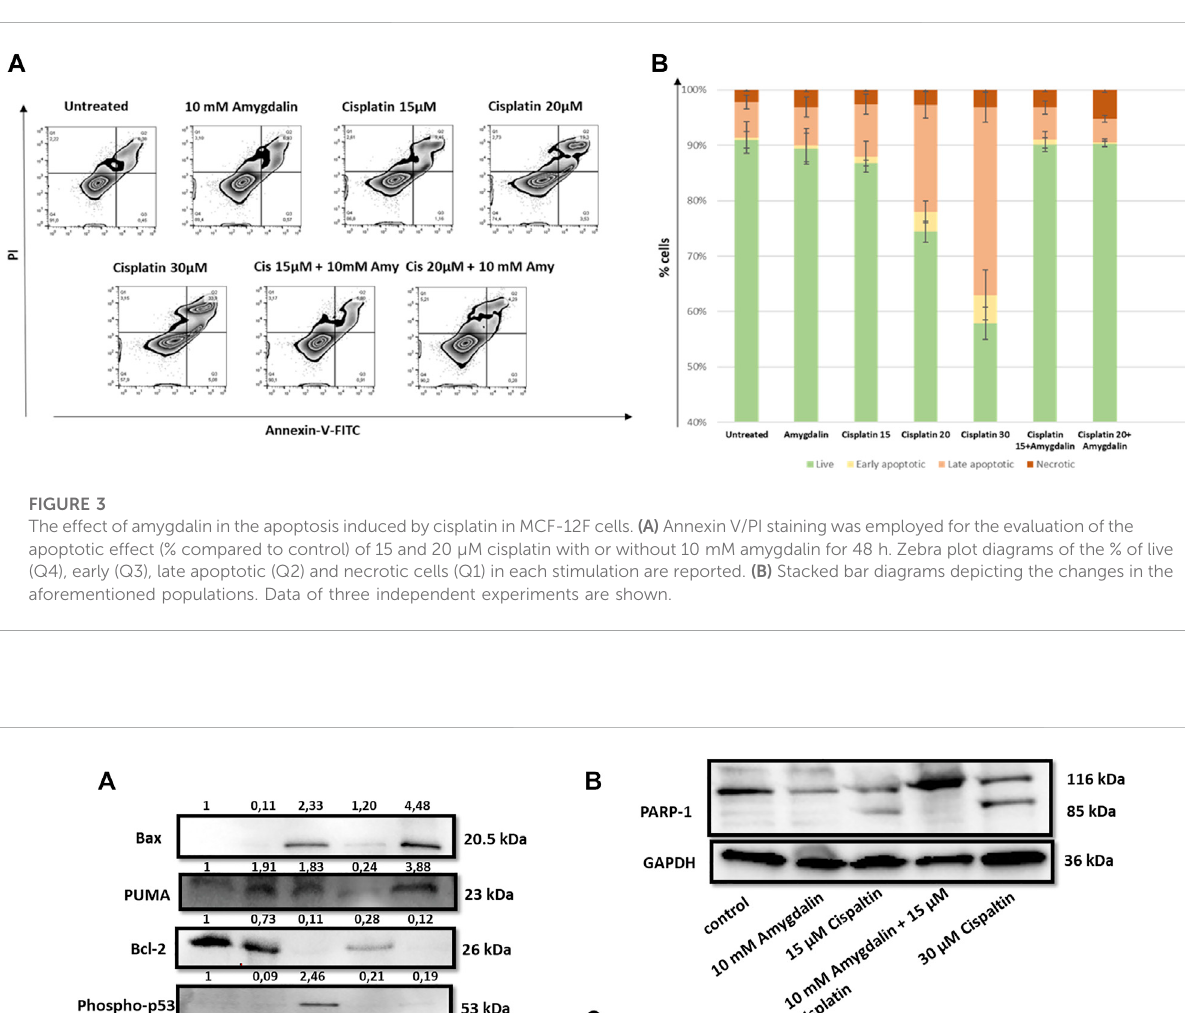
necrotic cells for all conditions of treatment are presented in Figure 3B. 30 μ M concentration was used since it was found to be the highest concentration able to kill more than 50% of the